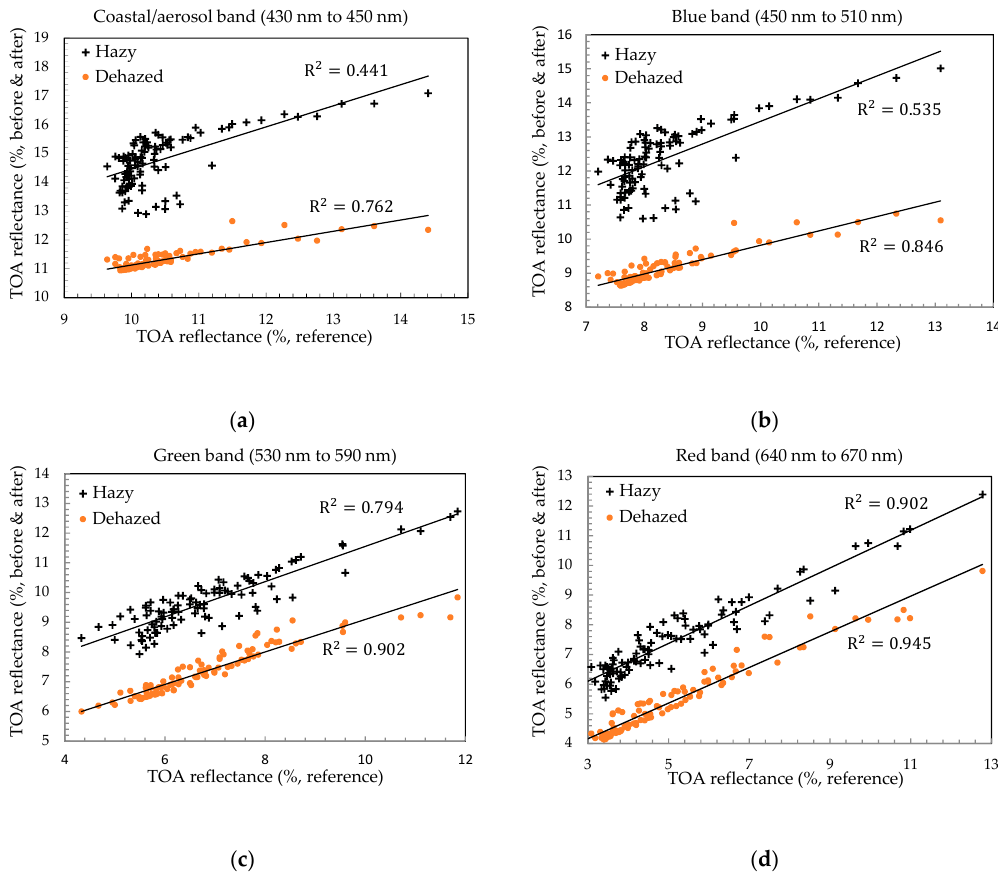
Figure 9. Scatter plots and correlations of the samples taken from hazy (crosses, scene ID: LC80290242014212LGN00) and dehazed (dots) versus the samples taken from reference (scene ID: LC80290242014228LGN00) images of four visible bands: ( a ) coastal/aerosol band (430 nm to 450 nm); ( b ) blue band (450 nm to 510 nm); ( c ) green band (530 nm to 590 nm); and ( d ) red band (640 nm to 670 nm).